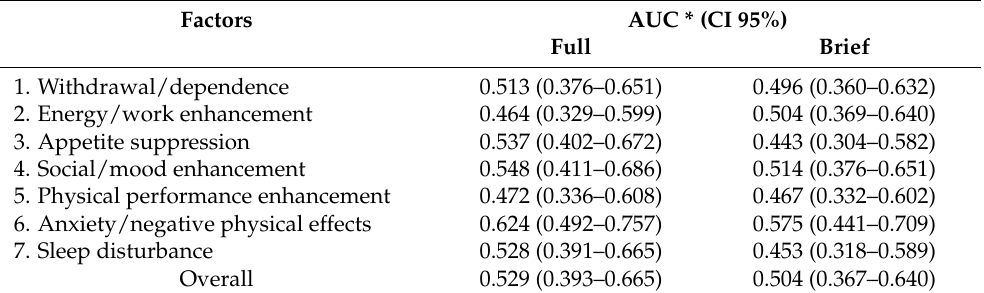
Table 3. Area under the ROC curve (AUC) of CaffEQ-BR full and brief versions for CYP1A2 genotypes. Factors